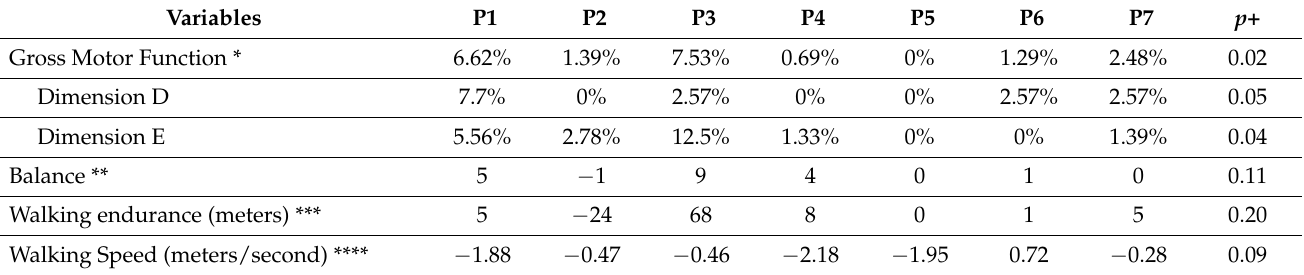
Table 3. Short-term effect of the intervention V 2 − V 1